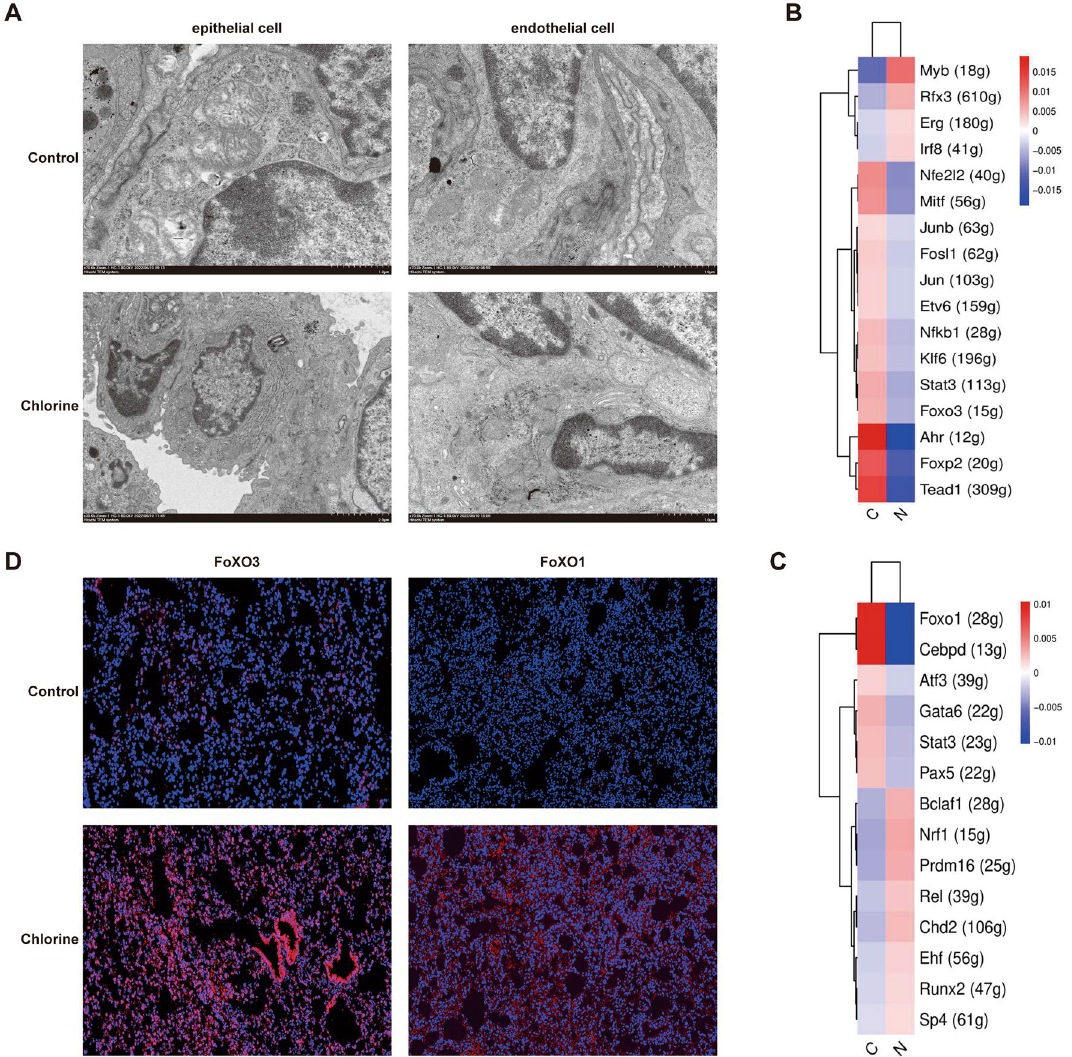
Figure 7. The expression of mice ferroptosis after Cl 2 exposure. ( A ) The transmission electron microscopy observation of epithelial and endothelial cells, scale bars 70 μm, n = 6. ( B , C ) SCENIC analyses of epithelial and endothelial cells in control and Cl 2 -exposed groups. ( D ) Immunofluorescence staining of FoXO1 and FoXO3 genes, scale bars 50 μm, n = 6, FoXO1 and FoXO3 (red), cell nuclear (blue), N control group, C Cl 2